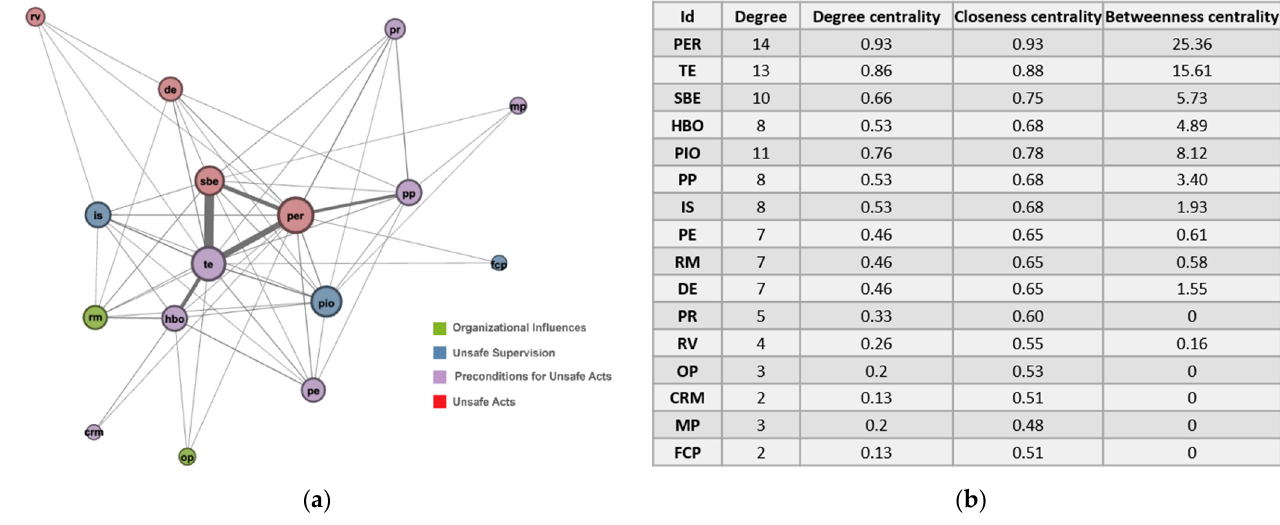
Figure 4. Holistic social network analysis result: ( a ) network analysis diagram; ( b ) network centrality analysis table.